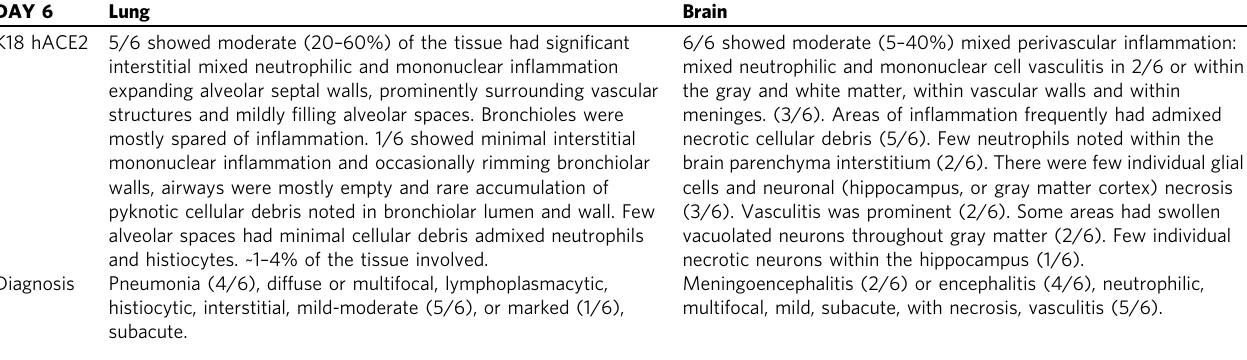
Table 2 Histopathology evaluation of SARS-CoV-2-infected K18 hACE2 transgenic C57BL/6 mice in Lung and Brain at 6 DPI. DAY 6 Lung Brain K18 hACE2 5/6 showed moderate (20 – 60%) of the tissue had signi fi cant interstitial mixed neutrophilic and mononuclear in fl ammation expanding alveolar septal walls, prominently surrounding vascular structures and mildly fi lling alveolar spaces. Bronchioles were mostly spared of in fl ammation. 1/6 showed minimal interstitial mononuclear in fl ammation and occasionally rimming bronchiolar walls, airways were mostly empty and rare accumulation of pyknotic cellular debris noted in bronchiolar lumen and wall. Few alveolar spaces had minimal cellular debris admixed neutrophils and histiocytes. ~1 – 4% of the tissue involved.